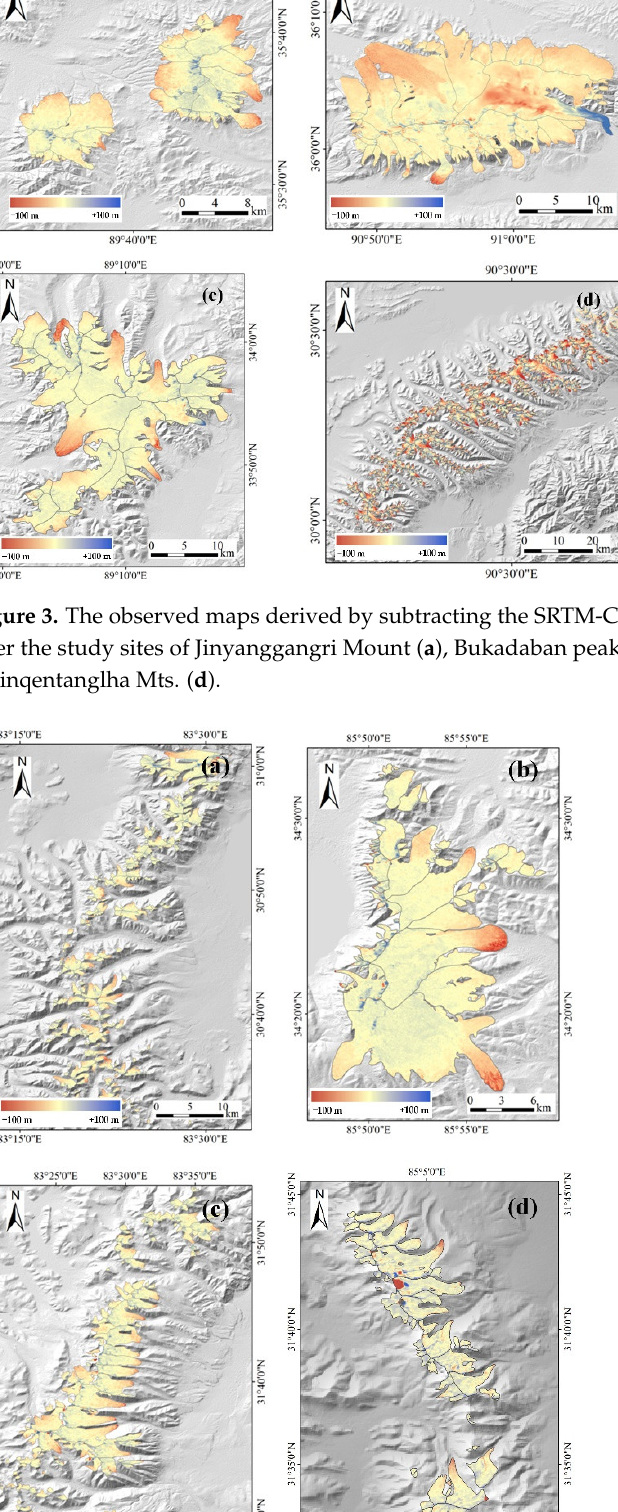
Figure 2. The maps of the observed glacier elevation changes from 2000 to the 2010s over the six study sites with a complete coverage of the SRTM-X DEM (See Figure 1, red rectangle areas). ( a ) Buruogangri Mount; ( b ) Songzhi peak; ( c ) NganglongKangri Mount; ( d ) Dongkemadi Mts.; ( e ) Muztagh peak; ( f ) Unnamed-3 Mts. The central Yulinchuan Glacier experienced a surging event from 2008 to 2009.